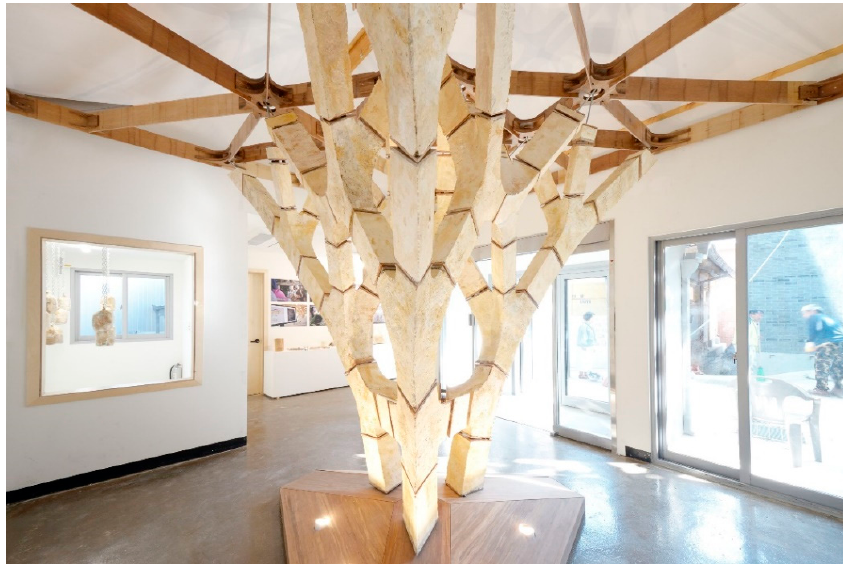
Figure 2. The Mycotree Pavilion (Image credit: Carlina Teteris).